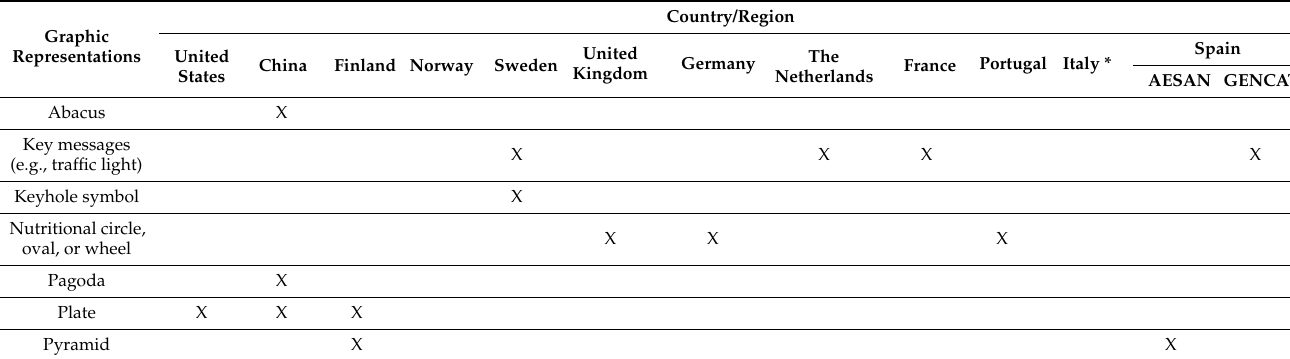
* The Italian guidelines do not include graphical representations. X: information included in the National Dietary